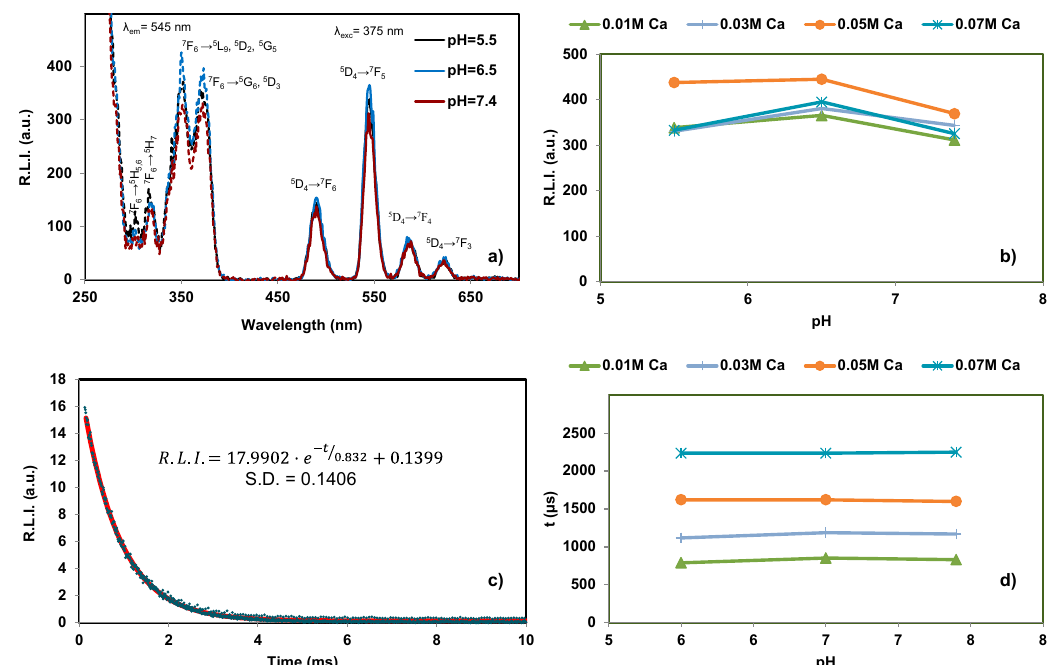
Nanomaterials 2021 , 10 , x FOR PEER REVIEW